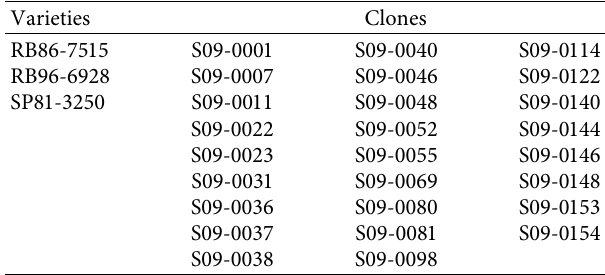
Table 1: Varieties and clones used in the